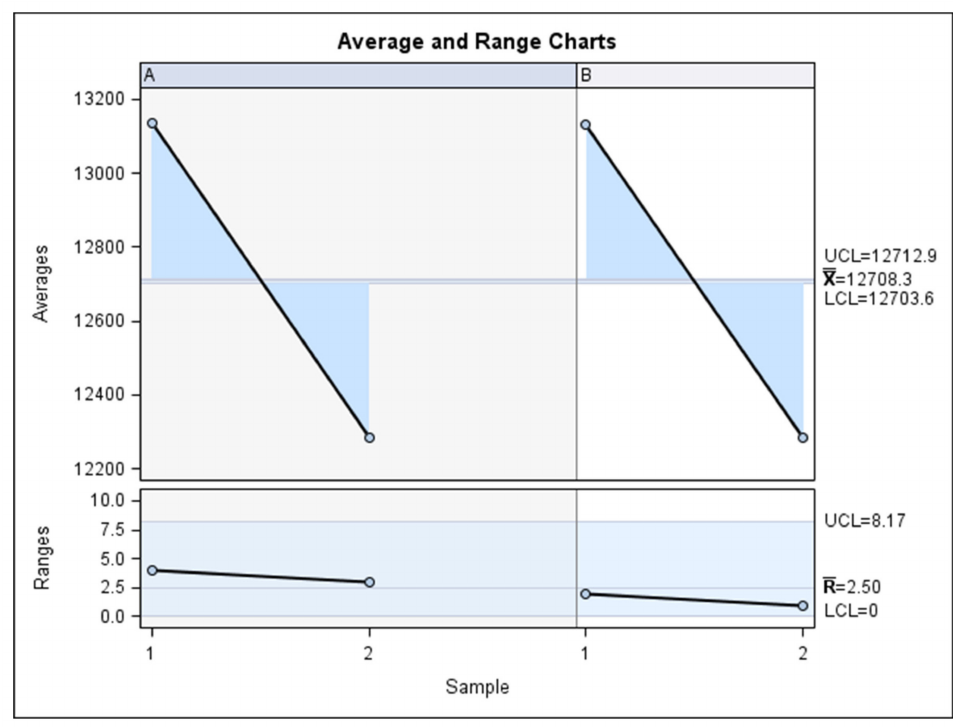
Figure 6. Charts for the average of the measures of the volume of the right maxillary sinus, left maxillary sinus, and the nasal and maxillary sinus airway complex as assessed by two operators.